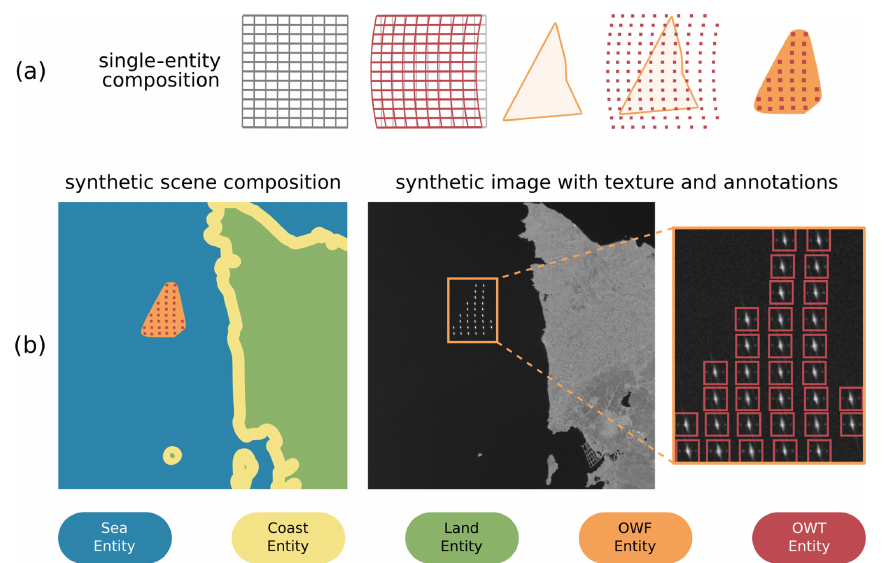
Figure 3. Simplified overview of a SyntEO workflow for automatic training example generation (Hoeser and Kuenzer, 2022a). Panel (a) vi- sualises how the structure of a single OWF entity is generated. Panel (b) shows how multiple entities are composed to a scene composition. The final image is generated by adding texture to the composed scene. The bounding box annotations are derived from the scene